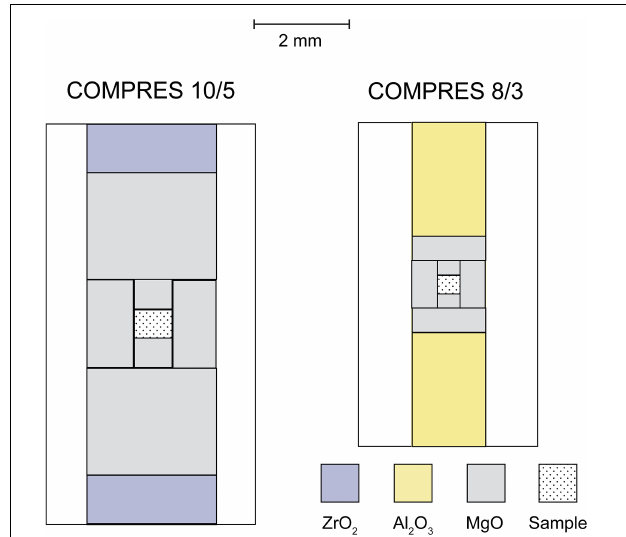
FIGURE 1 | Configurations of cell assemblies for high-pressure experiments. Left: cross-section of modified COMPRES 10/5 assembly showing the sample (dotted) with a MgO container (gray), MgO spacers (gray), and zirconia end-plugs (blue). Right: cross-section of modified COMPRES 8/3 assembly showing the sample (dotted) with a MgO container (gray), MgO spacers (gray), and alumina end-plugs